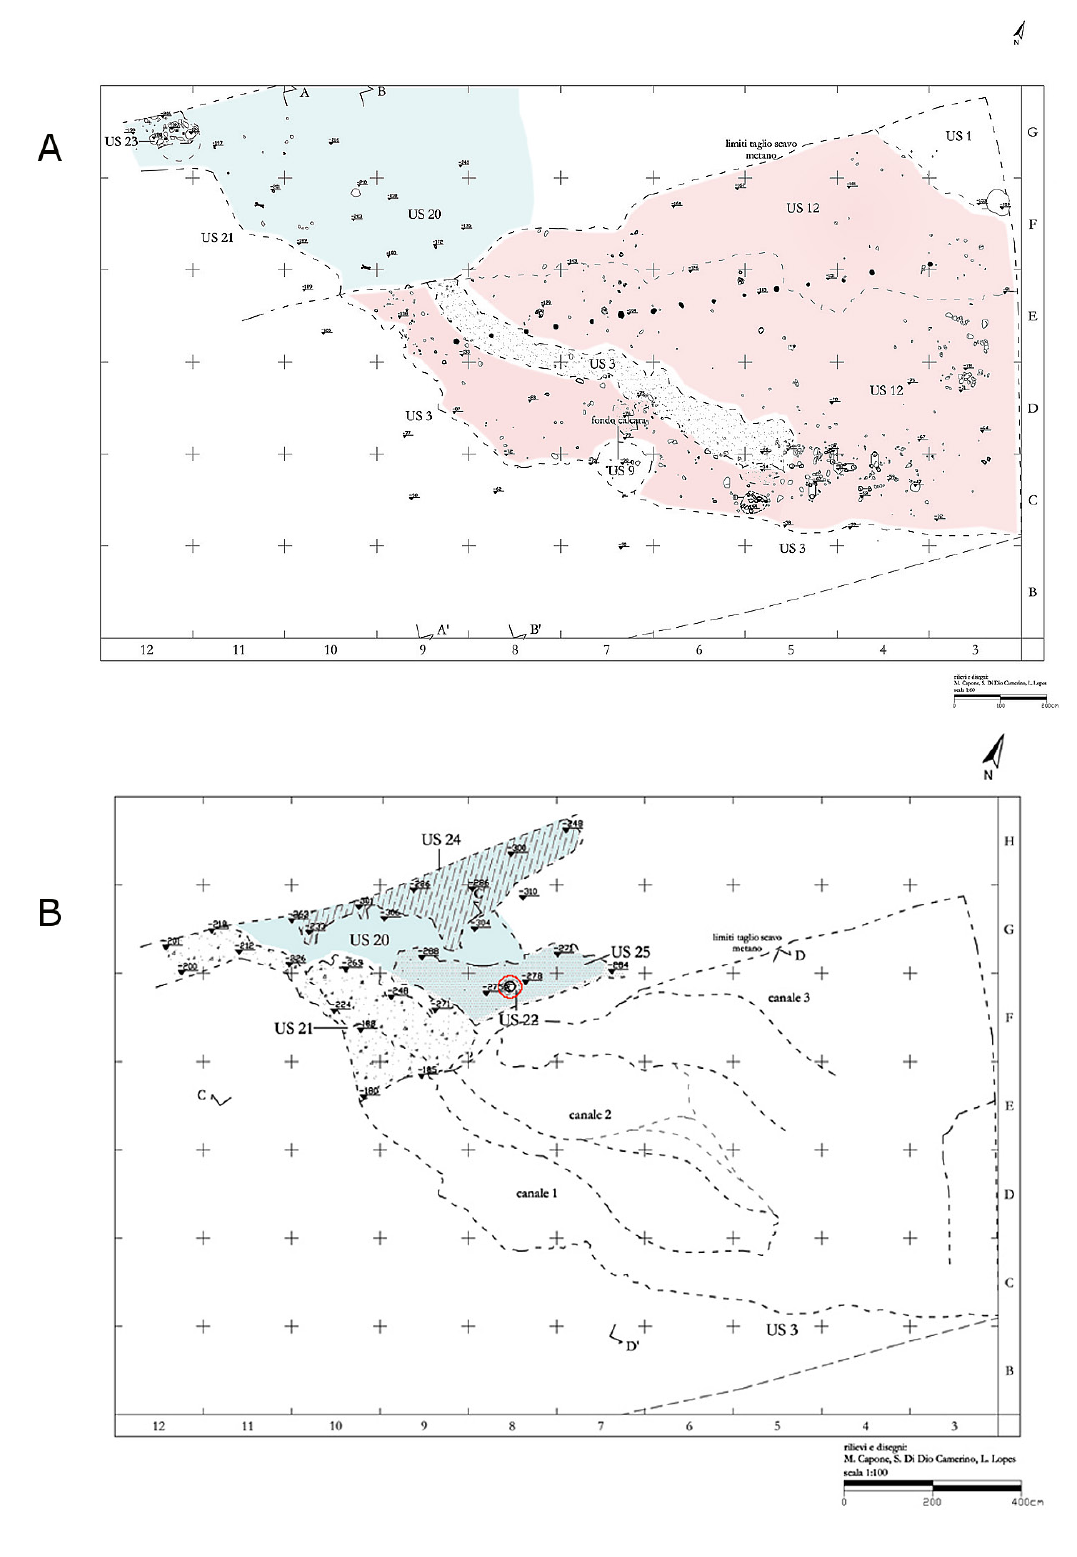
Figure 2. S. Martino excavation plant: A. Diana culture layer 12 in pink color and Stentinello culture layer 20 in blue color; B. Stentinello culture layers 20-25-24 and the bowl SU 22, in blue color; in the lower part there are the paleo-channels filled by the layer